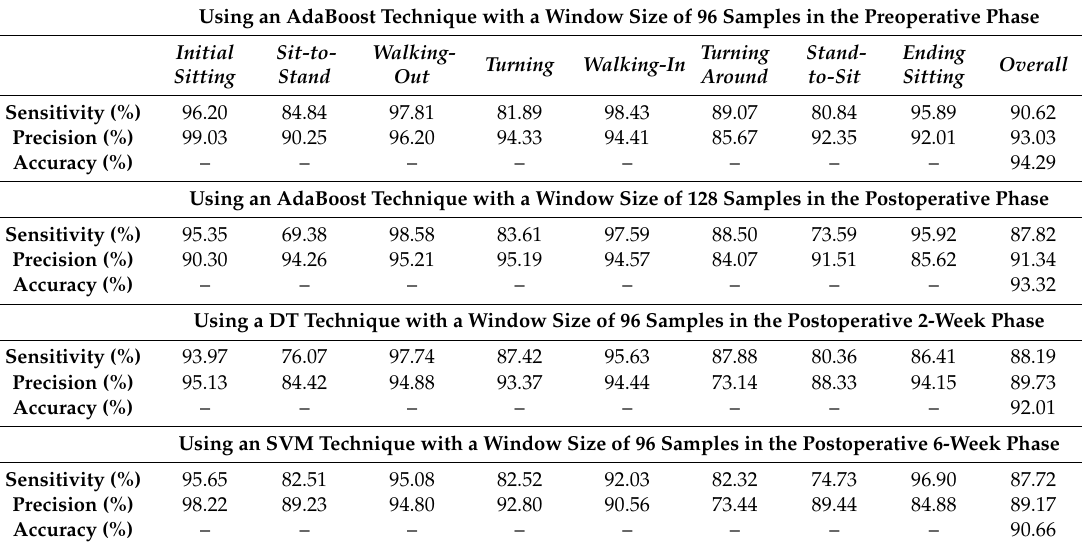
Table 4. The performances of each subtask (highest performances of each